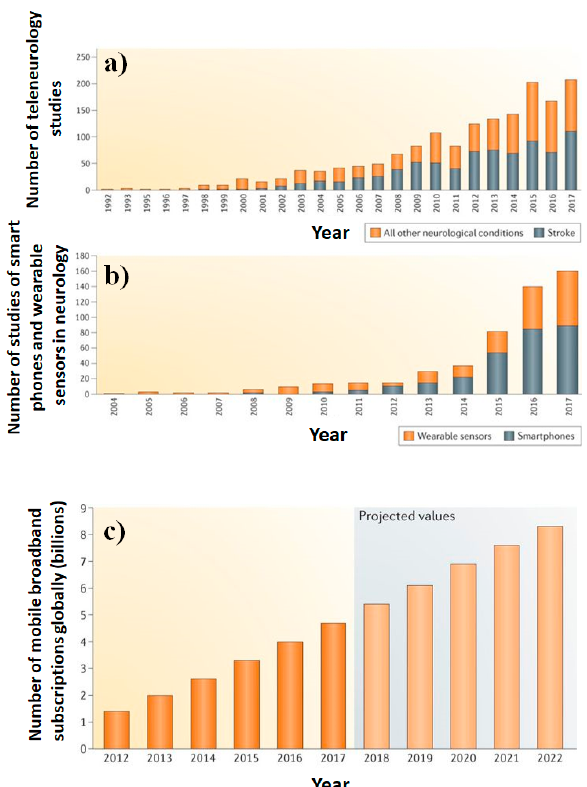
Figure 7. Proliferation of teleneurology studies. ( a ) A graph showing the volume of published studies of telehealth and care delivery for stroke (grey) and other neurological conditions (orange) from 1992 to 2017, as listed on PubMed. The past two decades have seen a substantial increase in the volume of these studies. ( b ) A graph showing the volume of published studies of smartphones (grey) and wearable sensors (orange) for neurological conditions from 1992 to 2017, as listed on PubMed. Few studies were conducted before 2015, but the number has since increased exponentially. ( c ) The number of mobile broadband subscriptions, globally. A graph of smartphone ownership (measured by a number of global broadband subscriptions) from 2012 to 2022. Smartphone (Ericsson Mobility Report, 2017) ownership rates have steadily increased; by 2020, 70% of the world’s population is projected to own a smartphone (images reproduced from [22] with copyright permission from Nature Review: Neurology).